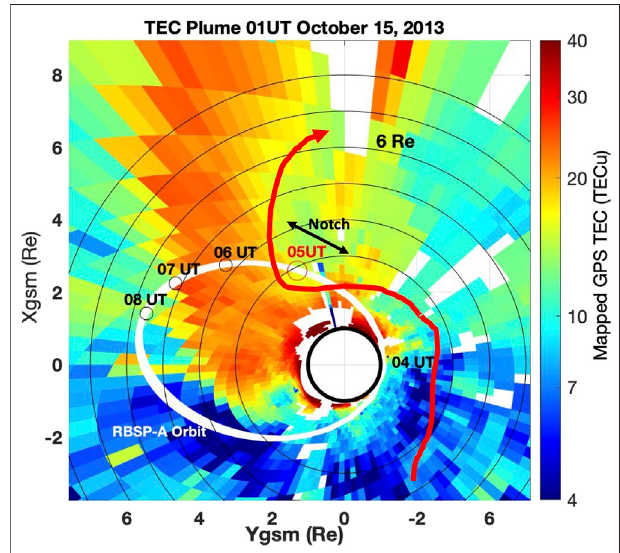
FIGURE 2 | RBSP-A orbit and orbital position at 05 UT on October 15, 2013 are superimposed on an equatorial-plane projection of ground-based GPS TEC observations. These latter are not indicative of absolute plasmaspheric density, but serve to trace boundaries of the geospace plume in the dayside magnetosphere [Foster et al. (2002)]. A schematic drift trajectory for < 10 keV ions injected sunward from themagnetotail isshown as a red curve. Crossing the “ notch ” between the outbound crossing of the dawnside plasmapause and the plume, the spacecraft intersects the injection trajectory of ions of a fi xed energy at two separate radial distances leading to the observation of a wedge-shaped ion fl ux distribution (e.g. Ebihara et al.,